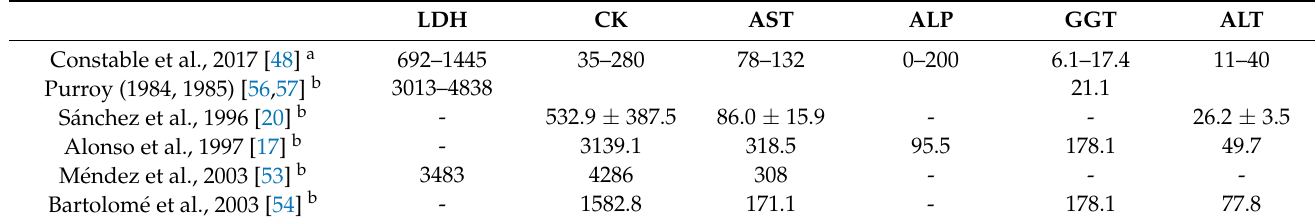
( ± 23.86), with values ranging from 2.04 to 104.10 nmol/L.